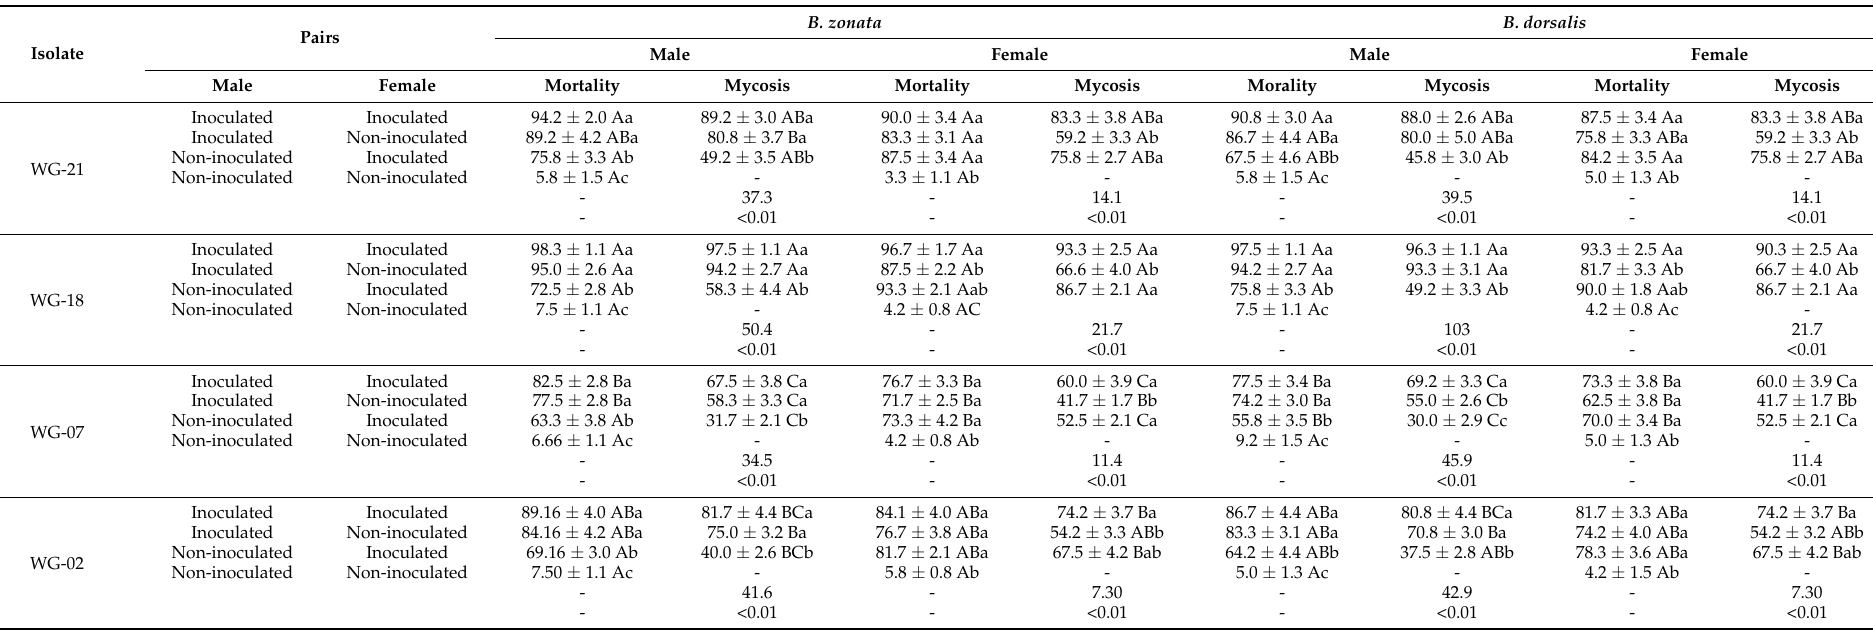
Table 9. Mortality and mycosis levels (% mean ± SEM) caused by horizontal transmission of entomopathogenic fungi (isolates WG-21, WG-18, WG-07, and WG-02) in adults of B. zonata and B. dorsalis recorded for four different adult pair combinations. Data were collected at 14 days post-inoculation. Upper case letters between the rows and lower case letters within the column indicate no significant differences between isolates for mortality and mycosis in inoculation methods ( p < 0.05; Tukey HSD test).